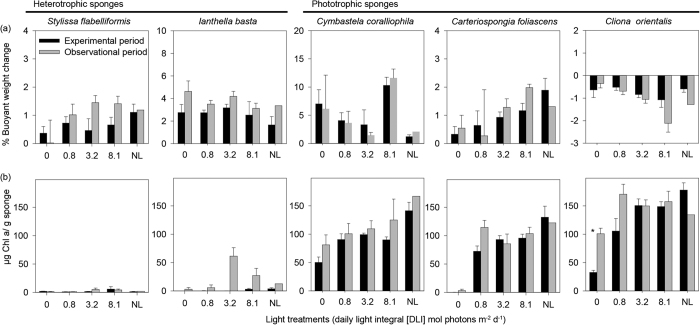
Physiological responses of sponges to light conditions.(a) Percentage buoyant weight change (note: y-axis scales differ between species), and (b) Chlorophyll a concentrations, for the five species, after the 28 d experimental period and 14 d observational period (mean ± SE). Asterisks show statistically significant differences between the experiment and recovery phase (T-tests: P < 0.05). Light treatments include 0, 0.8, 3.2, 8.1 mol photons m−2 d−1 and natural light (NL, 3.2–6.5 mol photons m−2 d−1).